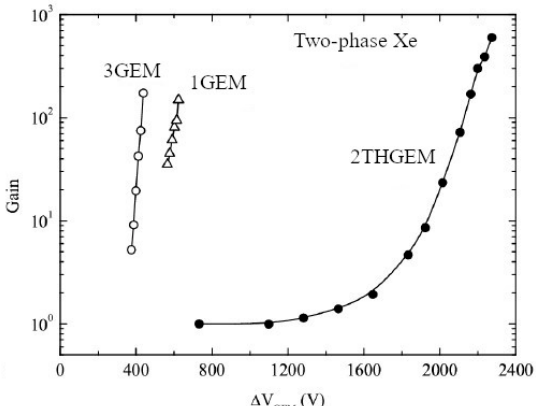
Figure 18. Gain characteristics of double-THGEM multipliers in two-phase Xe detector for THGEM active area of 2.5 × 2.5 cm 2 [4,70]. Gain characteristics of triple-GEM [40] and single-GEM [71] multipliers (of similar active area) are shown for comparison. Here the maximum gains were limited by discharges.